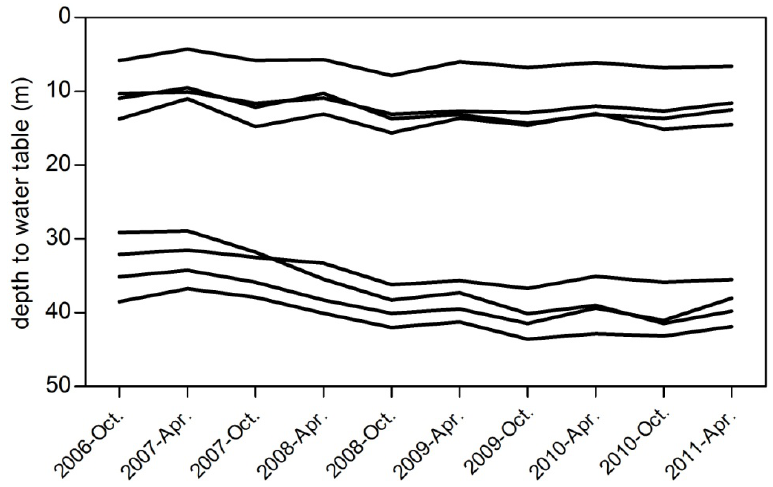
Figure 8. Depth to the water table in observation wells pre- (October) and post-wet season